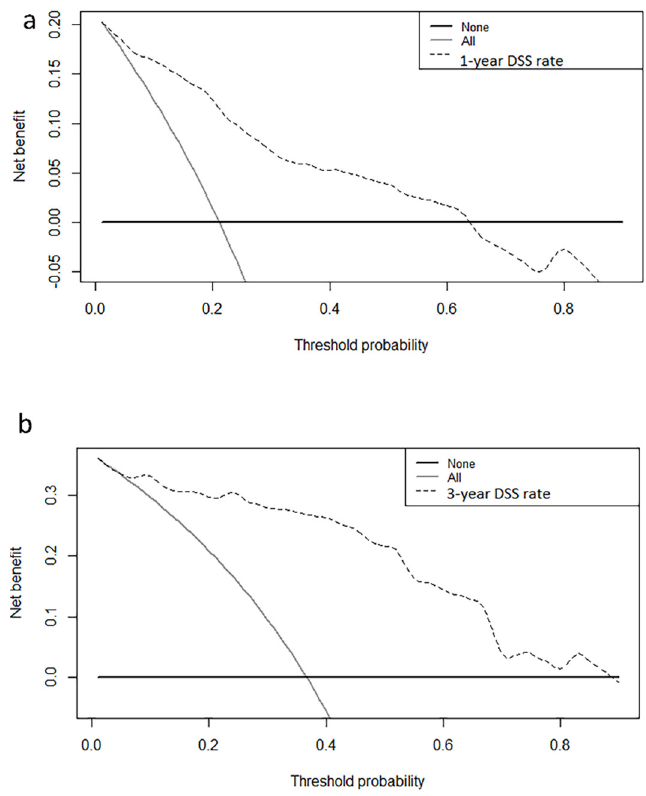
Figure 7. The decision curve analysis of the ( a ) 1-year disease-specific survival rates, ( b ) 3-year disease-specific survival rates for the training and validation cohorts.